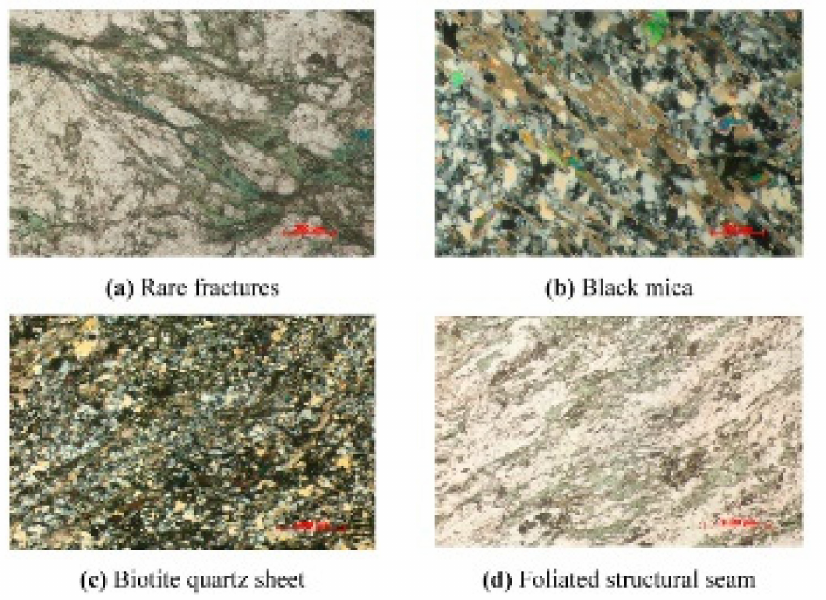
Figure 19. Thin-section photomicrograph of sandstone core from the Jilin oilfield showing mineral heterogeneity: ( a ) Biotite quartz sheet and ( b ) Foliated structural seam [79]. Therefore, a robust evaluation of formation damage should involve the simultaneous assessment of reservoir rock–fluid interaction at the wellbore face, inner wellbore face, for- mation face, and inner formation face (Figure 20). This can be achieved with a combination of micro computed tomography ( µ CT) and SEM/EDS